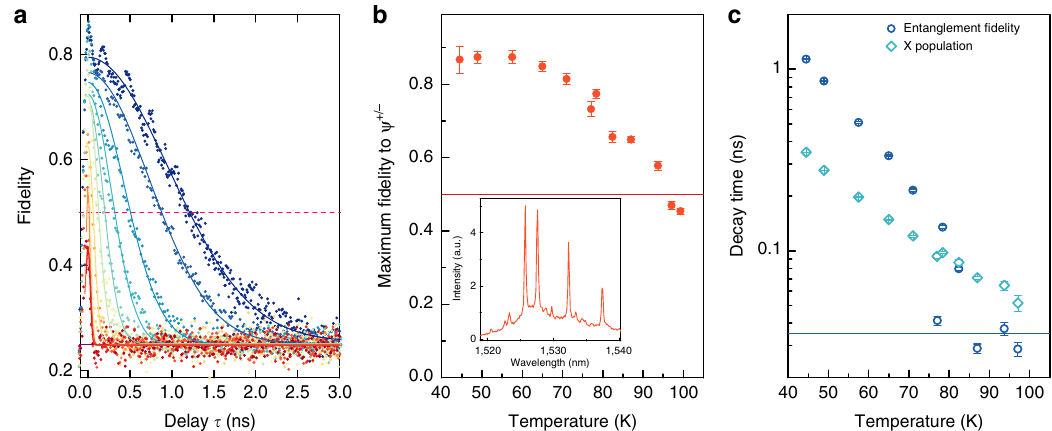
Fig. 3 Entanglement at elevated temperatures. a Fidelity to an evolving maximally entangled state when increasing the sample temperature from 44 K (dark blue) to 99 K (dark red) for a constant driving voltage of 1.8 V. Measured data (solid dots) are fi tted with a Gaussian decay (solid curves) and the classical threshold of 0.5 is indicated by the dashed pink line. b Maximum fi delity to the ψ + state as a function of temperature, where the error bars are the SD deduced from Poissonian statistics on the correlations. Again, the classical limit is indicated by the solid red line. Inset: dot spectrum at 63 K. c Entanglement decay time constant extracted from the Gaussian fi ts in a (blue circles) and X decay time (turquoise diamonds), with the error bars giving the SD calculated from the fi t covariance matrix. The half-width half-maximum (HWHM) of the detector timing resolution relevant for this measurement is around 30 – 34 ps, as shown by the solid blue